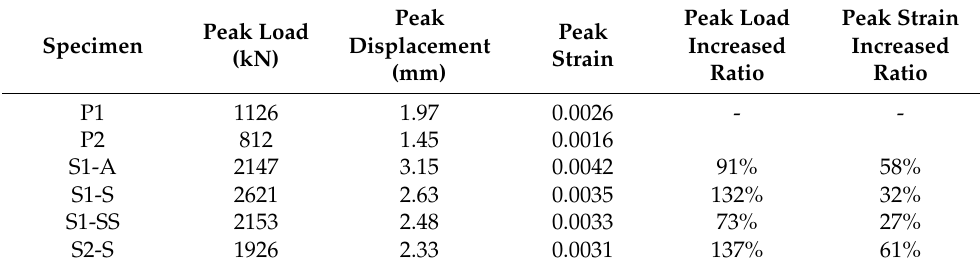
Table 7. Results of the axial compression